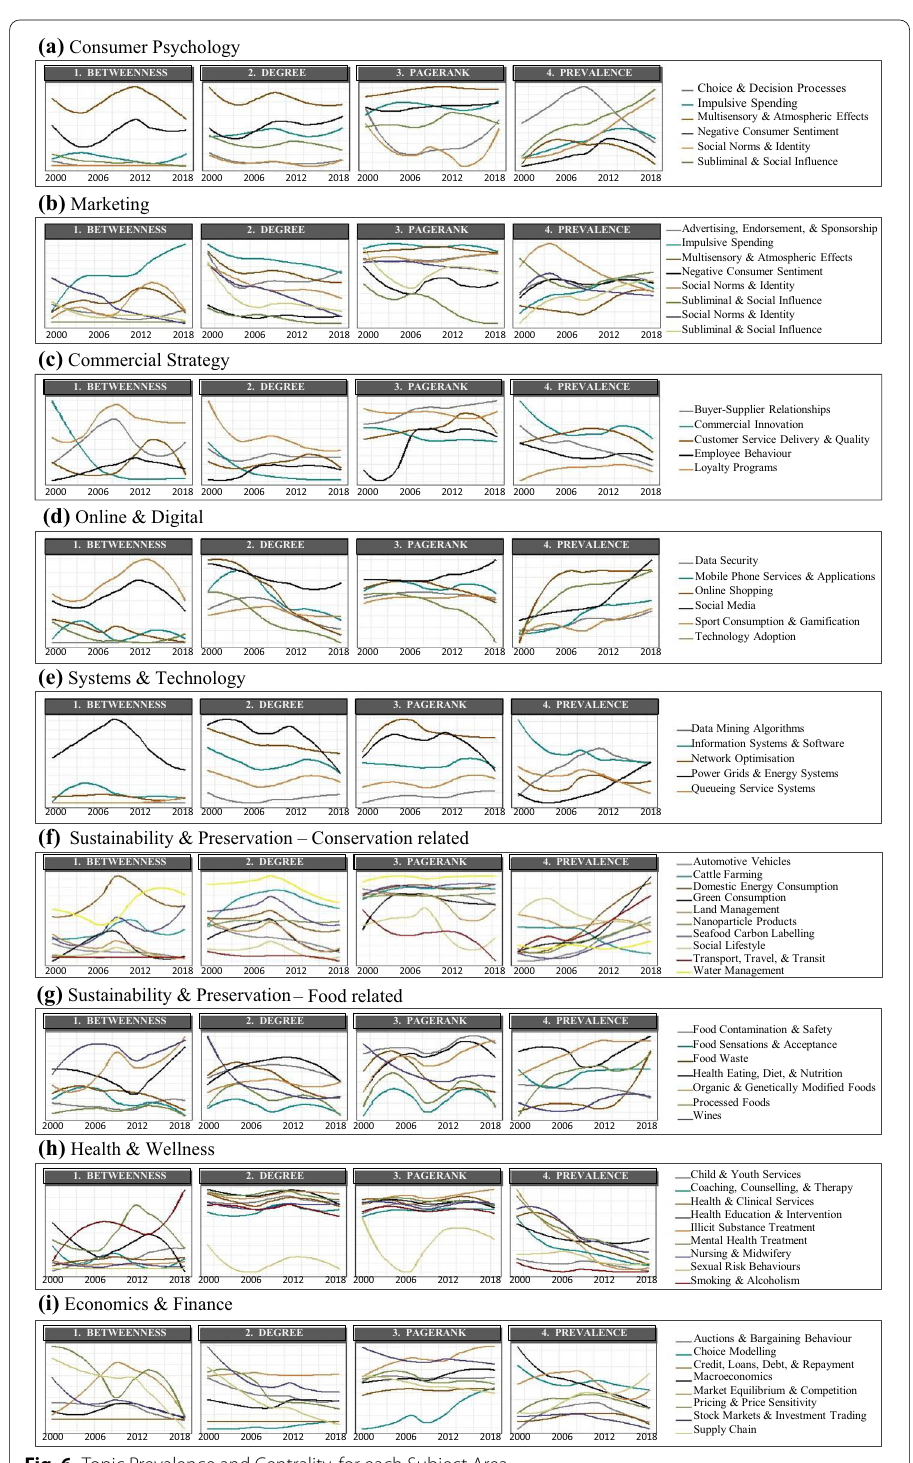
Fig. 6 Topic Prevalence and Centrality, for each Subject